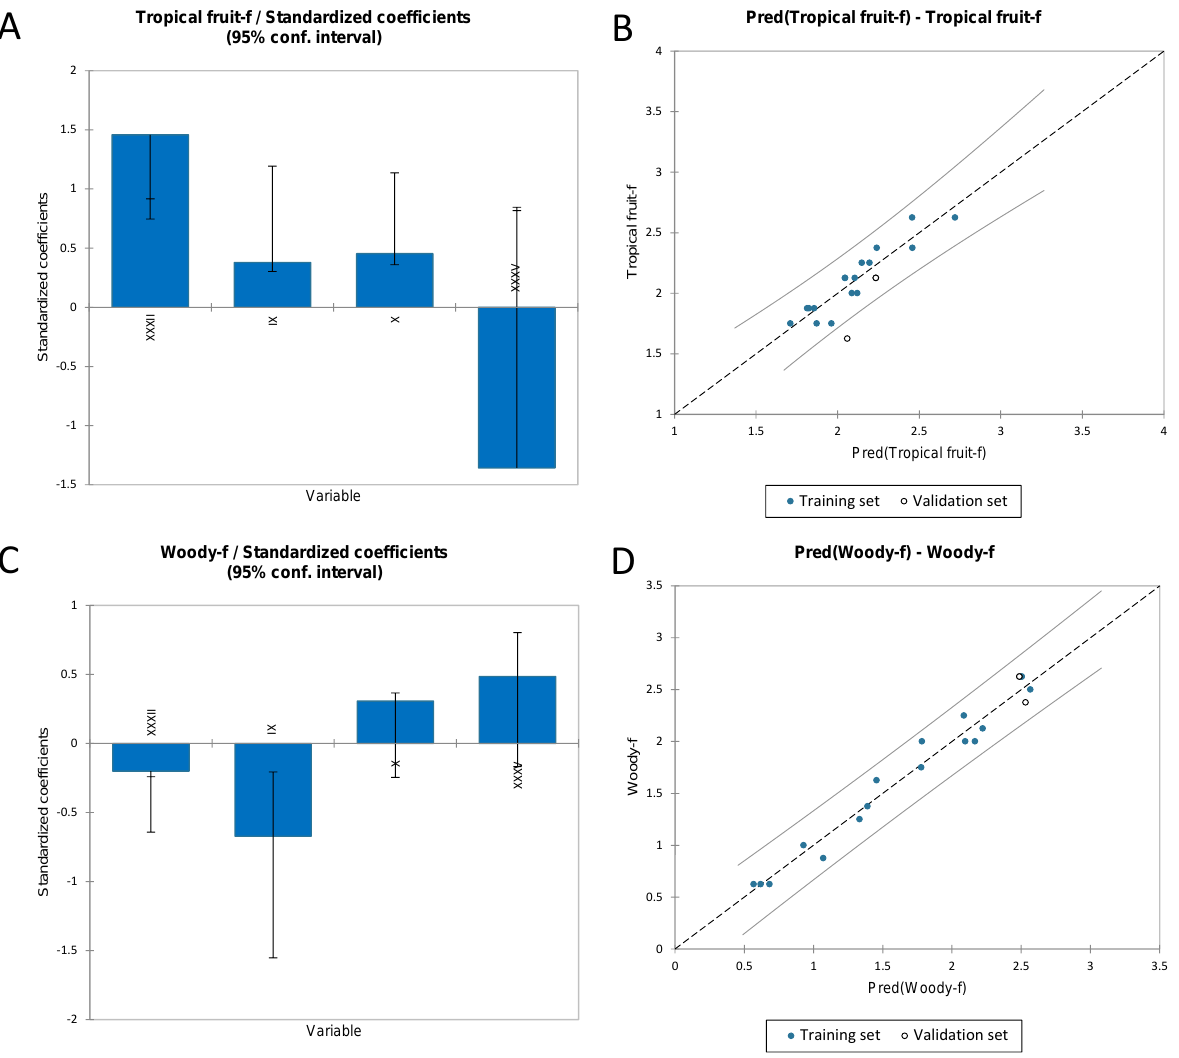
data related to the colour “green” and “warmness” were inside the confidence interval; both the colour “yellow” and “sourness” had one data point that was outside of the confidence interval. Additionally, Figure S7A (in Supporting Information File S1) shows the VIPs, which were in order of importance: x.11, x.68, x.115, x.96, x.169. Figure S7B–M shows the standardised coefficient effect in the regression.